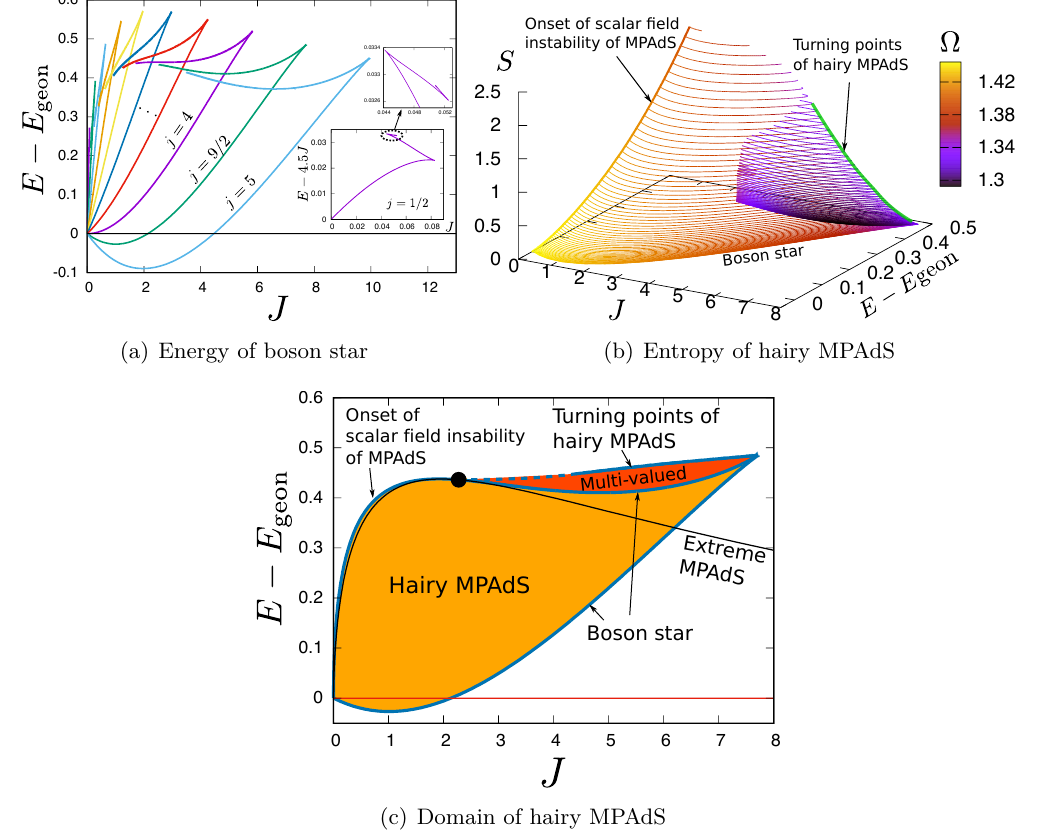
Figure 4 . (a) Energy of boson stars as a function of the angular momentum J . The existence of multiple turning points are shown in the insets for j = 1 / 2 . (b) Entropy of the hairy MPAdS for k = j = 9 / 2 , parametrized by J and E − E geon . The solid curve on the left edge indicates the onset of the scalar field superradiant instability of the MPAdS, from which the hairy MPAdS branches off. (c) Domain of existence of the hairy MPAdS. In orange and red regions, the hairy MPAdS exists. In the red region, the entropy and other physical quantities become multi-valued because of the turning